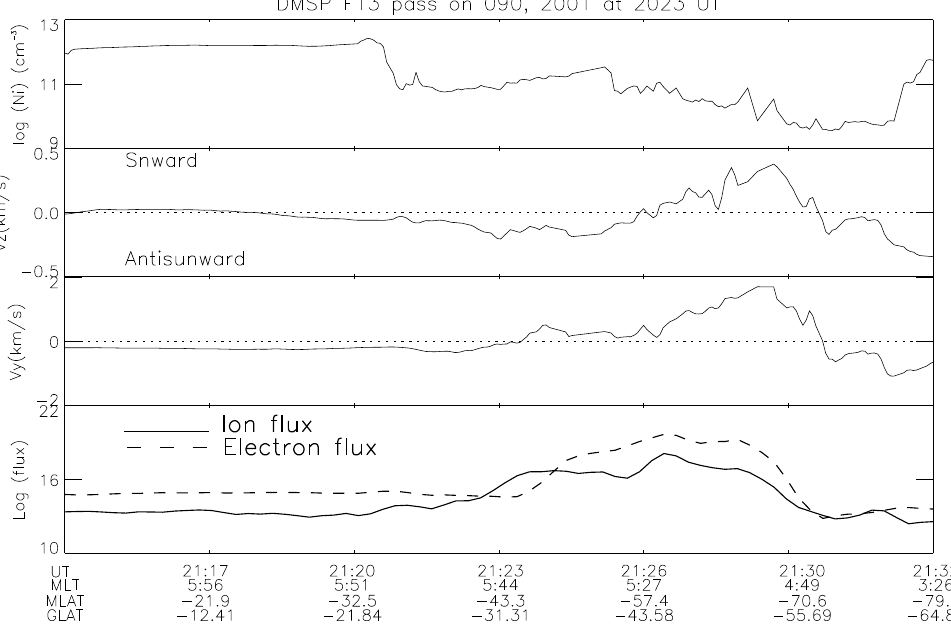
Fig. 8. The topside F-region plasma density (top), up and down (sunward and antisunward) plasma drift velocity (second from top), horizontal plasma velocity (third from top), and ions and electron flux (bottom) obtained from the DMSP 13 satellite when it cross the Australian east- coast region.